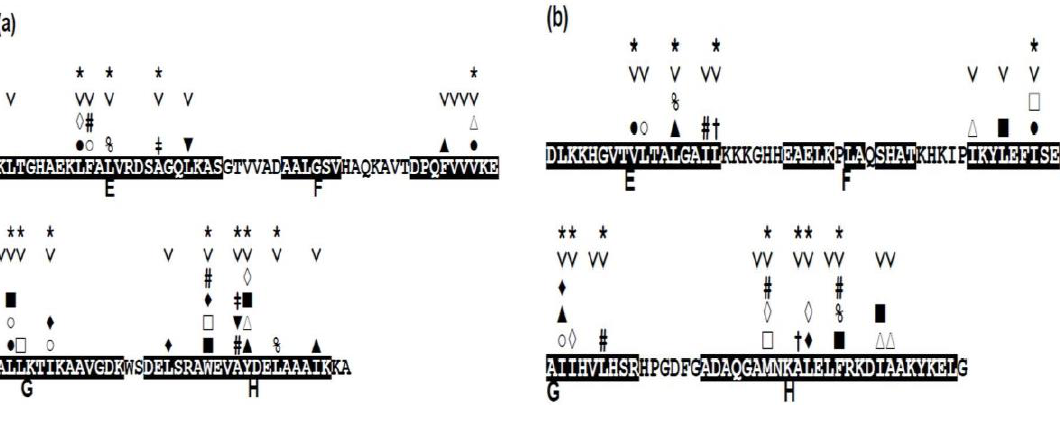
Figure 8. Conserved hydrophobic residues in the E-to-H helix unit of ( a ) 1FSL, ( b ) 1MBN, ( c ) 1R8J, ( d ) 1XL3, ( e ) 2FM9, ( f ) 2NP5, and ( g ) 2P06. The conserved residues are labeled with the mark “˅”. Any two residues with the same mark (one of the marks, #, %, ‡, †, ▲ , ▼, ■, □, ○, ◊, and ∆ ) in different helices denote that this residue pair makes a hydrophobic packing detected by the buried surface. Residues with “*” in a helix constitute a common residue pattern specific for the E-to-H helix unit. The residue with “*” actually does not form hydrophobic packing. For ( e ) 2FM9, ( f ) 2NP5 and ( g ) 2P06, a residue with a mark “+” indicates a residue pattern similar to one of the present common residue patters in Table